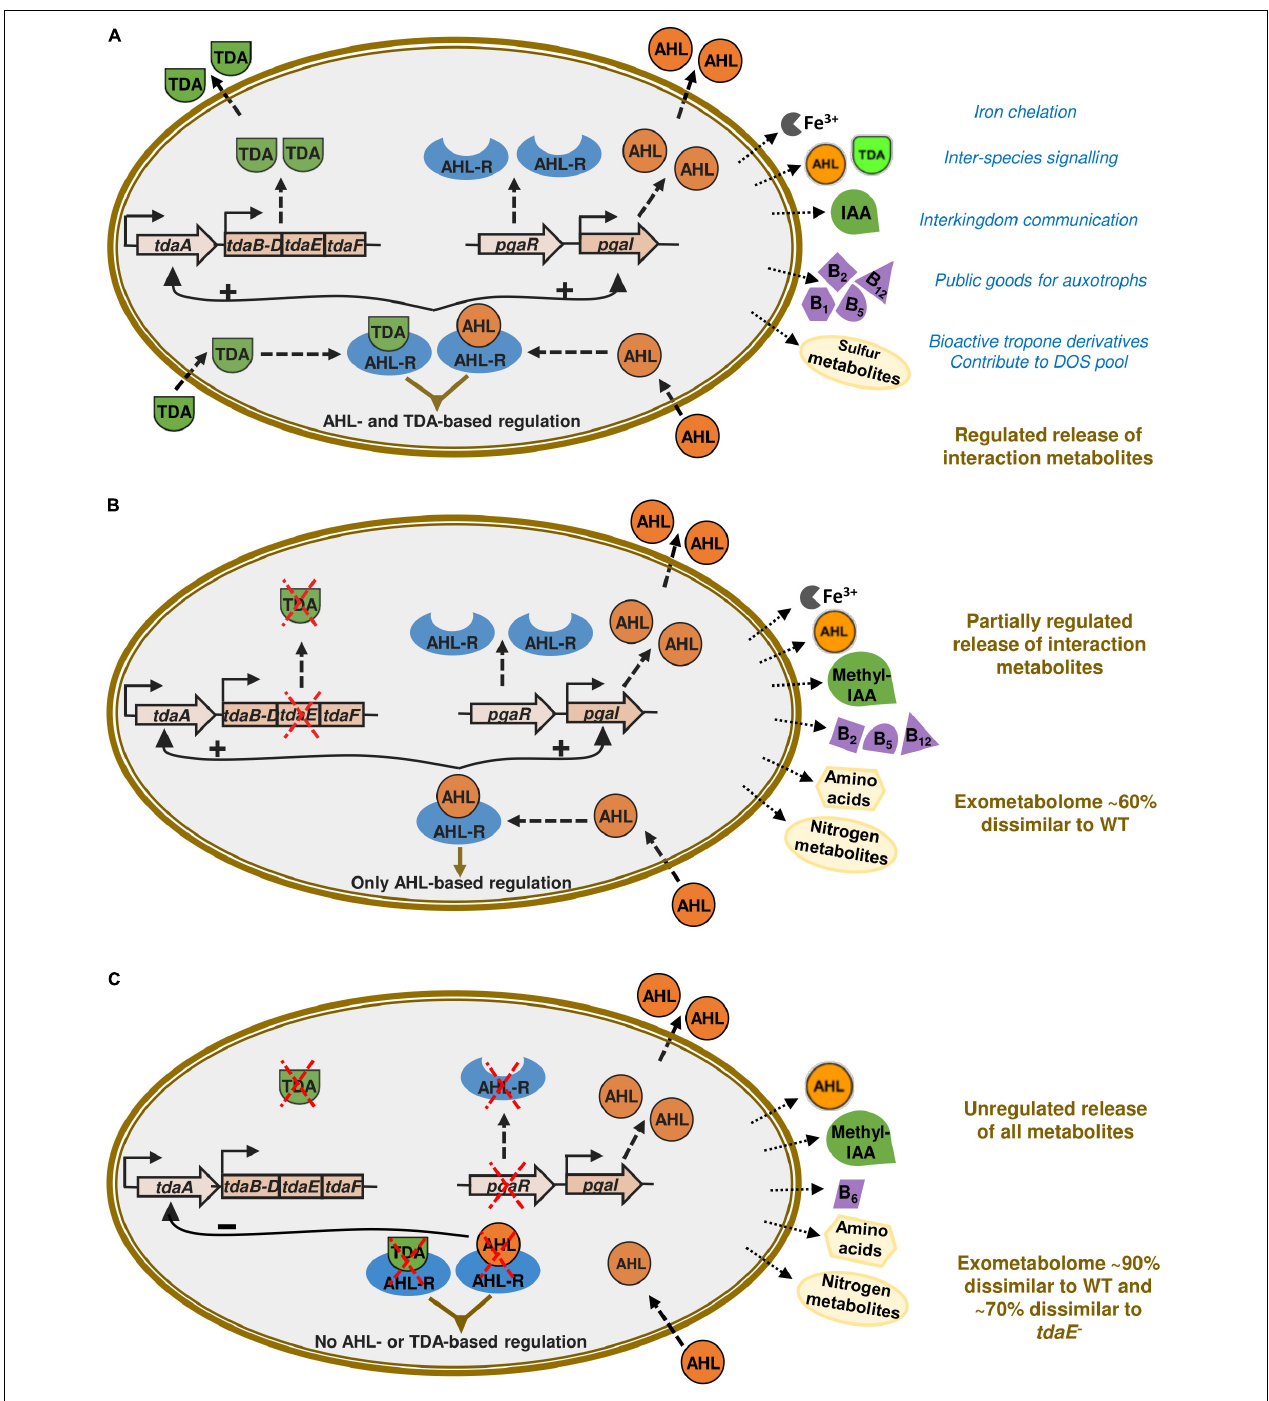
FIGURE 4 | Impact of TDA and AHL signaling on exometabolome of P. inhibens DSM 17395. The pgaR gene is encoding for the N -acyl-homoserine lactone regulator (AHL-R) and pgaI for the AHL synthase. The tdaA gene encodes the transcriptional regulator for the tropodithietic acid (TDA) biosynthesis gene cluster, tdaB-F . The observed impact of TDA and AHL-mediated global regulation on the exometabolome based on differential detection of ecologically relevant metabolites is indicated by arrows outside the cells. In the wild type (A) , AHL and TDA molecules interact with the AHL regulator to regulate global gene expression. This signaling also results in upregulation of TDA and AHL biosynthesis genes. In pure cultures of the tdaE − mutant (B) , there is an intact AHL-based regulation, but no TDA production due to a non-functional tdaE gene. Therefore, TDA-based regulation is absent resulting in the absence of certain interaction metabolites such as vitamins and auxins. In the pgaR − mutant (C) , there is neither AHL- nor TDA-based regulation since there is no regulator for the molecules to bind to. This results in the unregulated release of nitrogen containing metabolites but many exometabolites vital for species interactions are absent. This figure is based on QS signaling model proposed by Beyersmann et al. (2017). The original figure is licensed under Creative Commons Attribution 4.0 International License (https://creativecommons.org/licenses/by/4.0/) thereby permitting modifications.